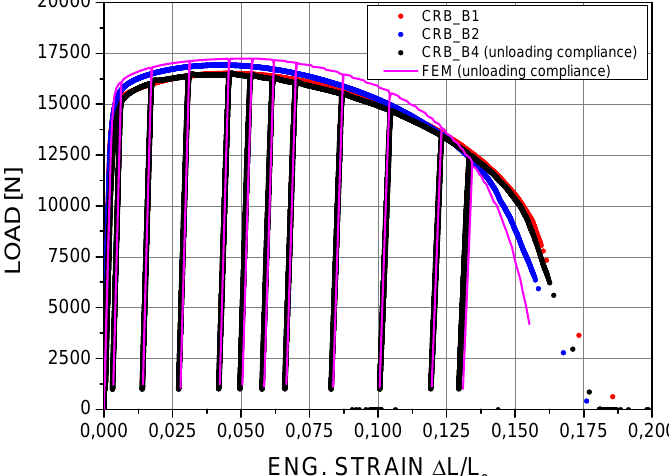
Figure 8: Comparison of applied load vs strain response measured in the tests and predicted with